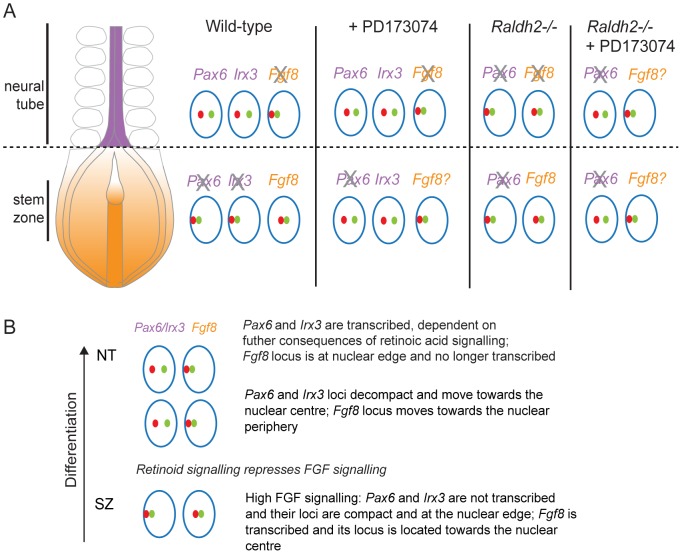
Changes in chromatin compaction and nuclear position of Pax6 and Fgf8 loci during neural differentiation and following manipulation of retinoid and/or FGF signalling.(A) Schematic summarising changes in local chromatin organisation of Pax6, Irx3 and Fgf8 loci as neural differentiation commences in the elongating body axis of wildtype and FGFR signalling deficient (+PD173074) and for Pax6 and Fgf8 in retinoid deficient (Raldh2−/−) mouse embryos and when both these signalling pathways are attenuated. These data indicate that FGF signalling promotes chromatin compaction around Pax6 and Irx3 loci and regulates nuclear position of Pax6, Irx3 and Fgf8 gene loci during neural differentiation. Green and red dots represent flanking fosmid pairs and blue circle the nuclear edge, grey cross indicates likely loss of active Fgf8. (B) Summary of chronological steps towards neural differentiation deduced in this study, from the high FGF signalling context in the stem zone to the onset of neural gene expression in the high retinoid signalling environment of the neural tube.